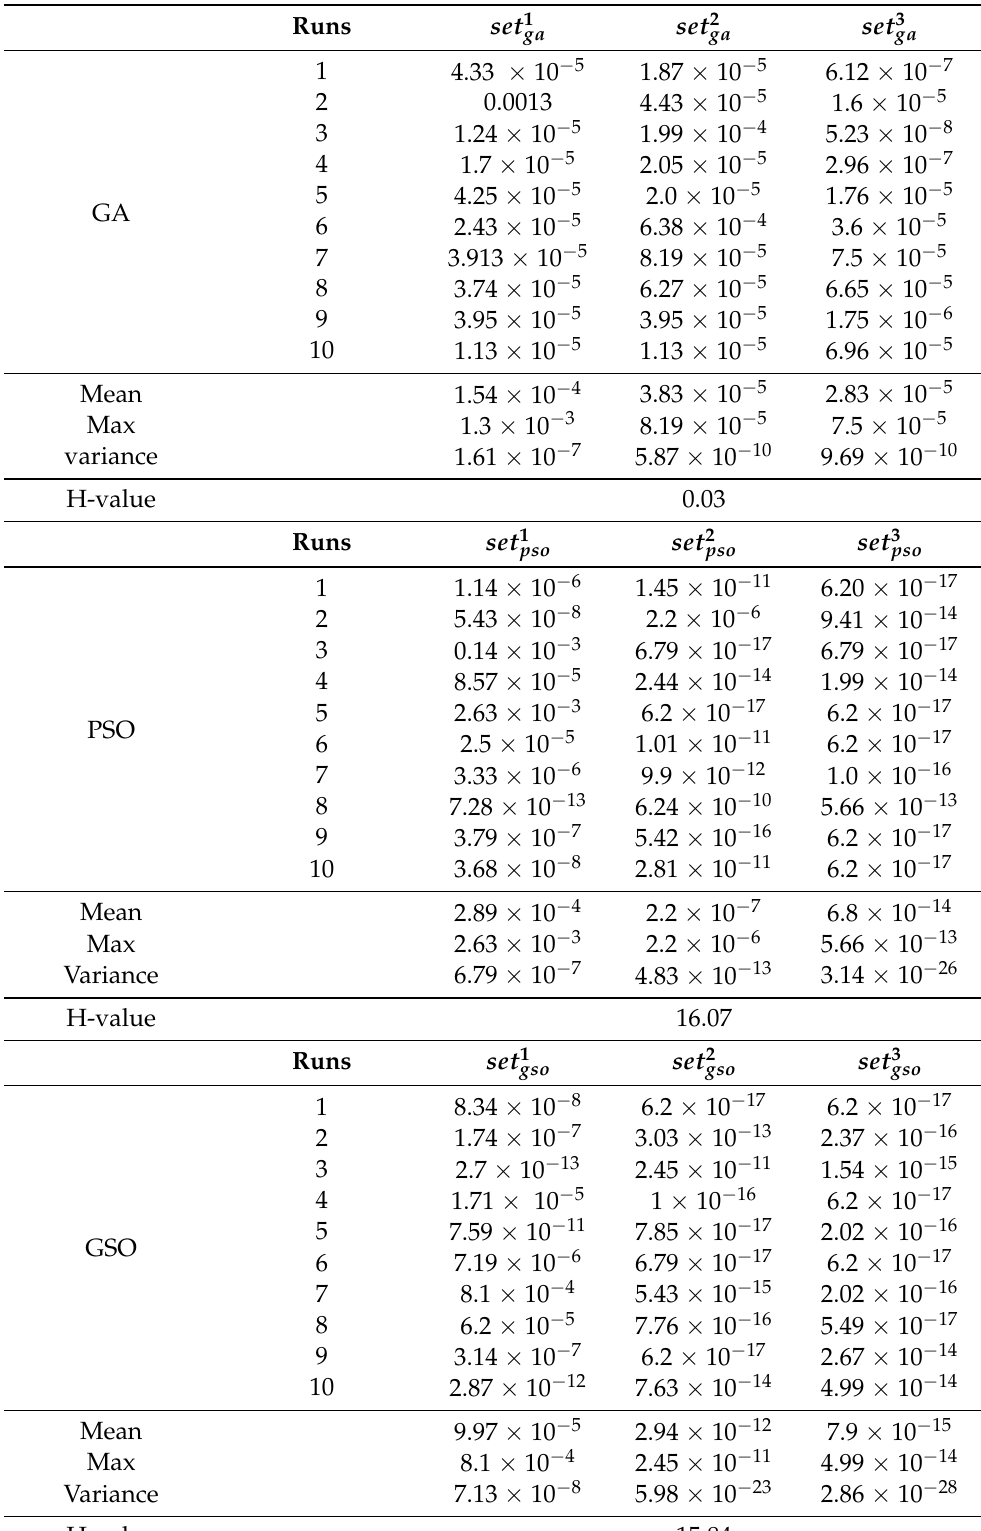
Table 3. Numerical analysis for the f obj of GA, PSO and GSO for various sets of